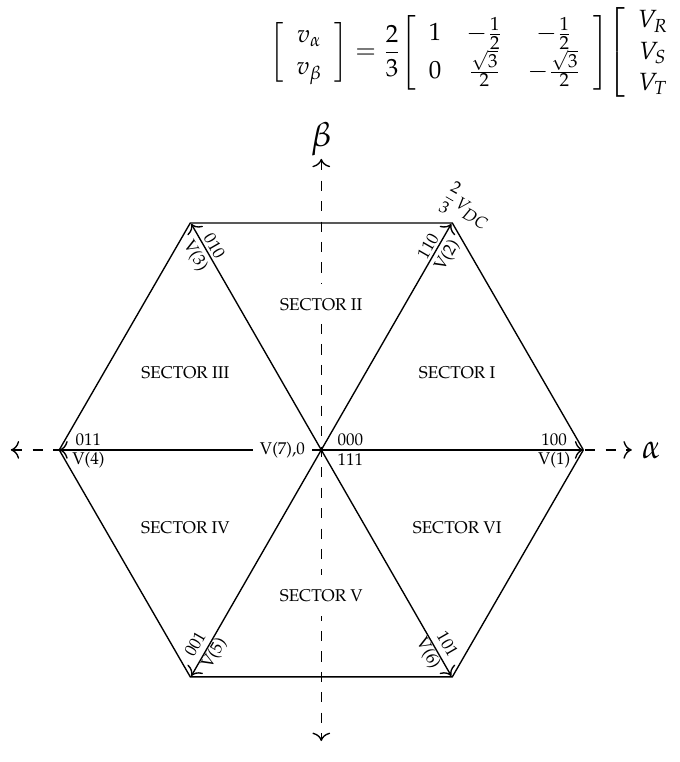
Figure 2. VSC vector diagram.